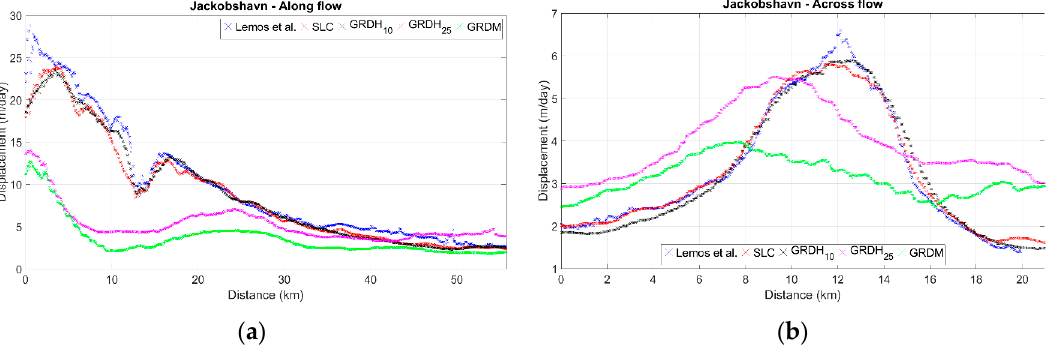
Figure 8. JAK, average annual flow speed for reference data (blue curve) and all the analyzed